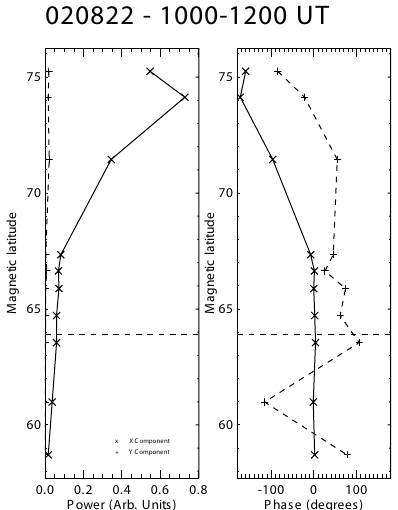
0.0 0.2 0.4 0.6 0.8 Power (Arb.